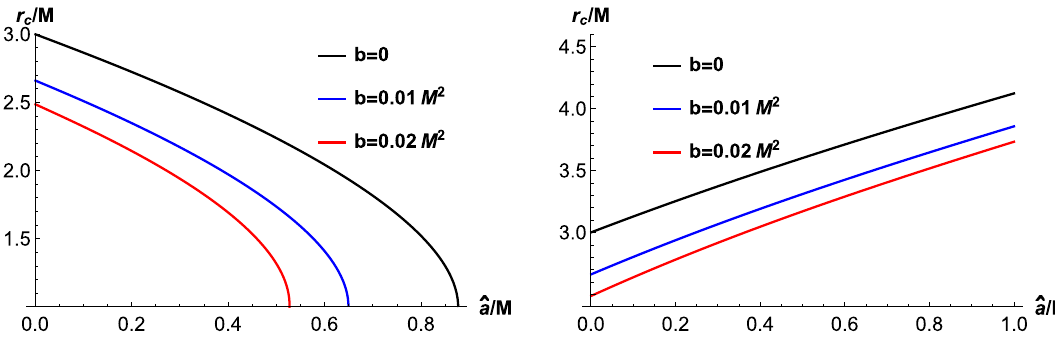
Fig. 14 Theleftpanelshowsthevariationofcriticalradiusforprogradeorbitsandtherightpanelshowsthevariationofcriticalradiusforretrograde orbits for various values of b with (cid:2) = 0 .